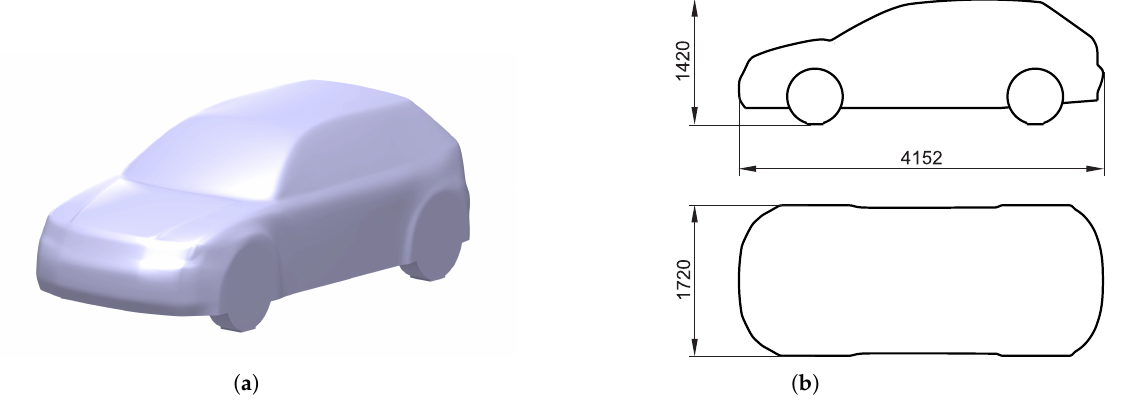
Figure 1. ( a ) Isometric view of the passenger car model geometry ( b ) Nominal dimensions of the car